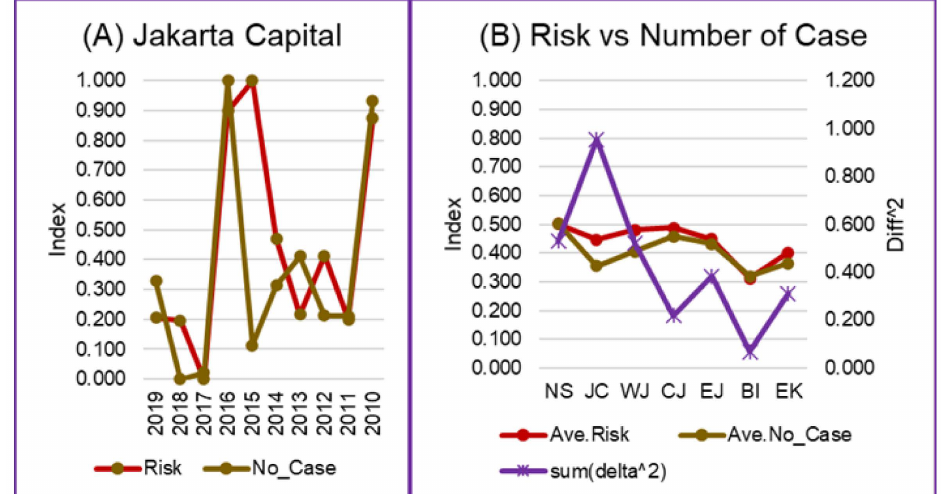
Figure 3. Risk and number of dengue cases comparison: ( A ) A comparison of the annual risk and number of dengue cases in the Province of the Jakarta Capital. ( B ) The comparison between the average risk and the average number of dengue cases in the seven analyzed provinces. Abbreviations: NS = North Sumatra, JC = Jakarta Capital, WJ = West Java, CJ = Central Java, EJ = East Java, BI = Bali, EK = East Kalimantan. (Graphs of the comparison of annual risk and number of dengue cases in other provinces can be seen in Appendix D, Figure A1).